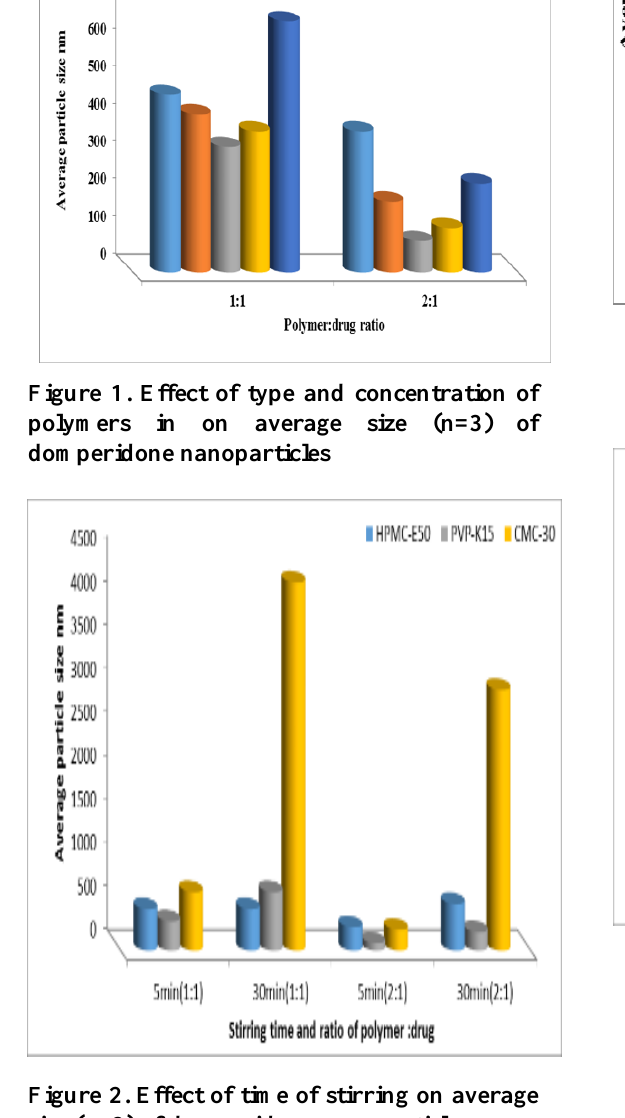
Figure 2. Effect of time of stirring on average size (n=3) of domperidone nanoparticles